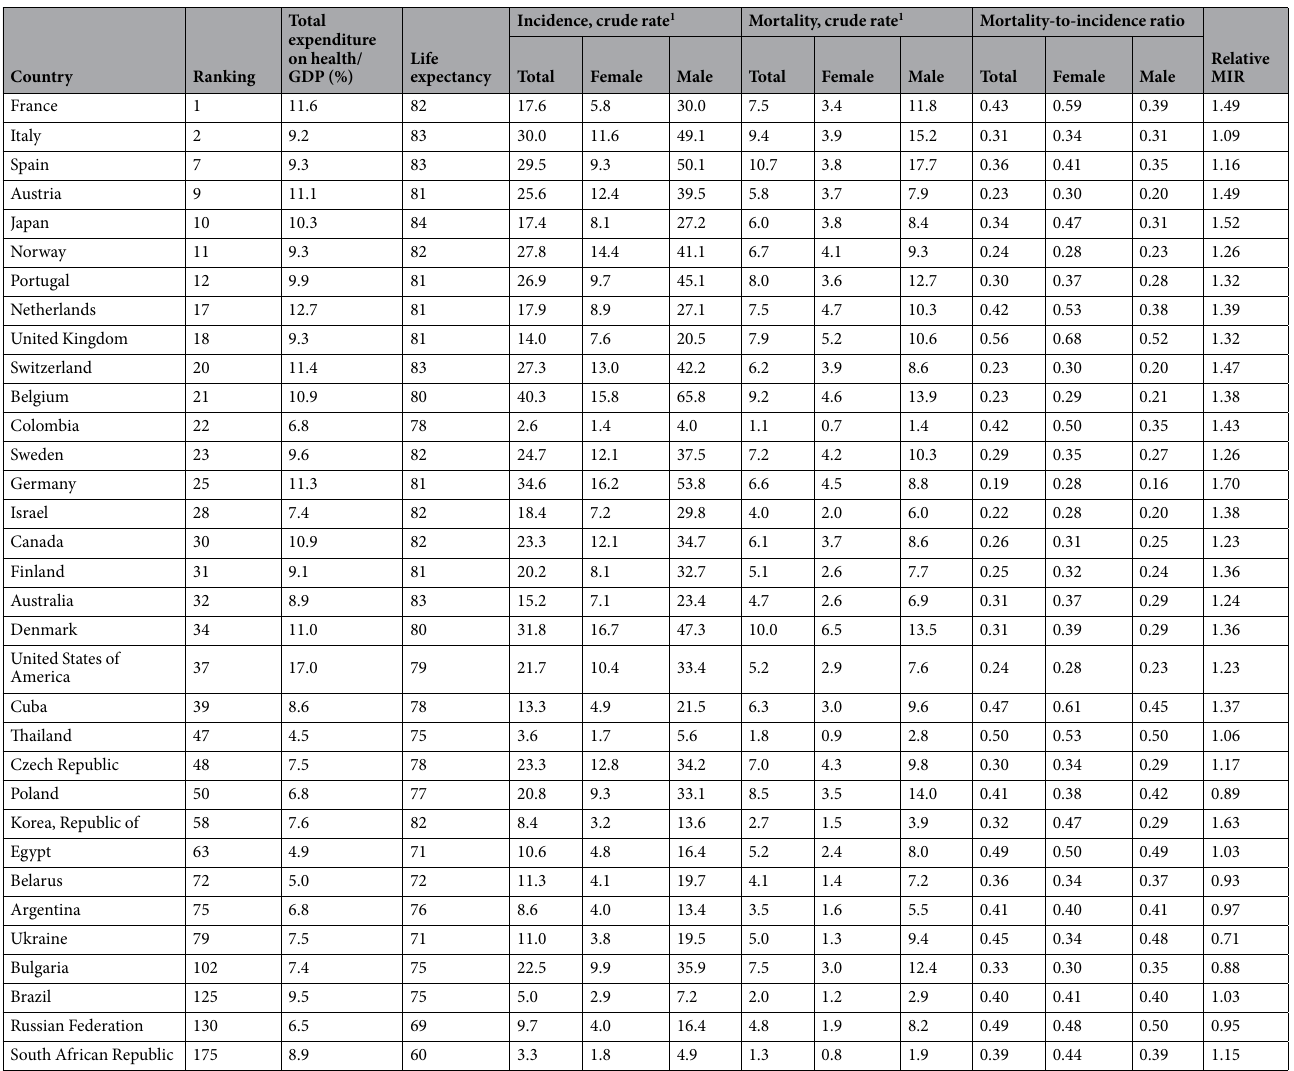
Table 2. Summary of World Health Organization ranking, total expenditure on health, life expectancy, bladder cancer incidence, mortality, and mortality-to-incidence ratio of 33 countries. 1 Crude rates were defined as the rates per 100,000.